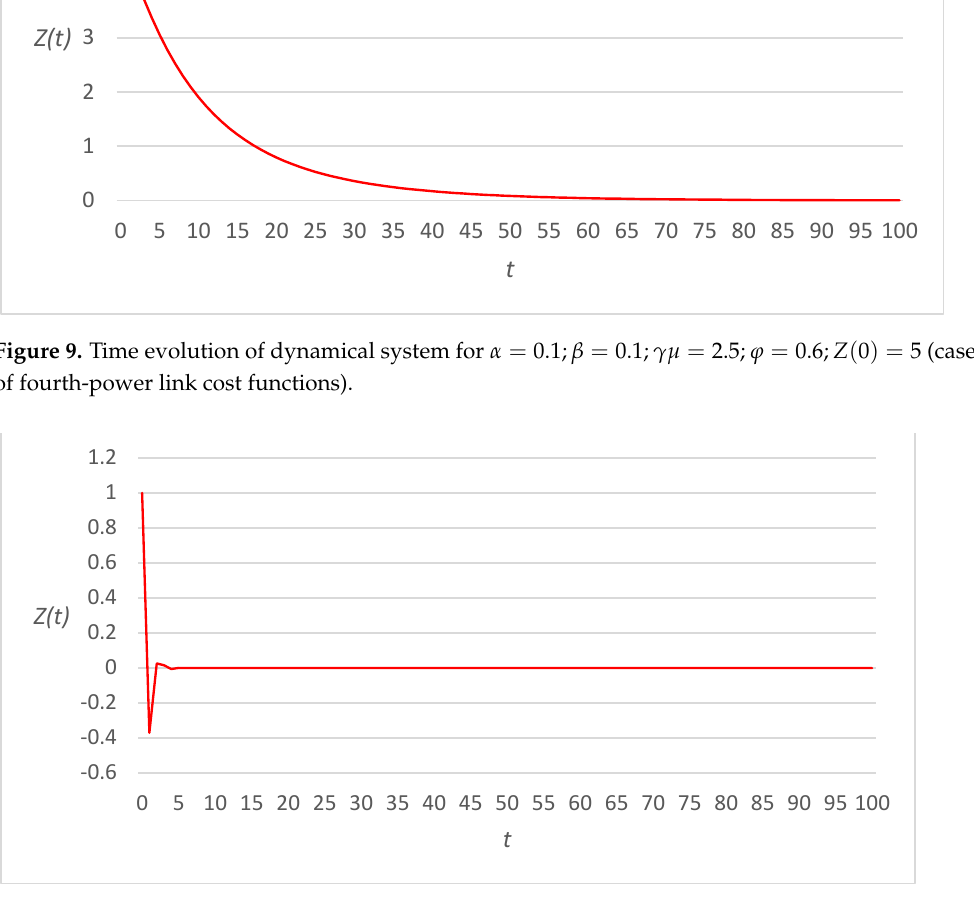
Figure 10. Time evolution of dynamical system for 𝛼 = 0.75;𝛽 = 0.75; 𝛾𝜇 = 10; 𝜑 = 0.23;𝑍(0) = 1 (case of fourth-power link cost functions).